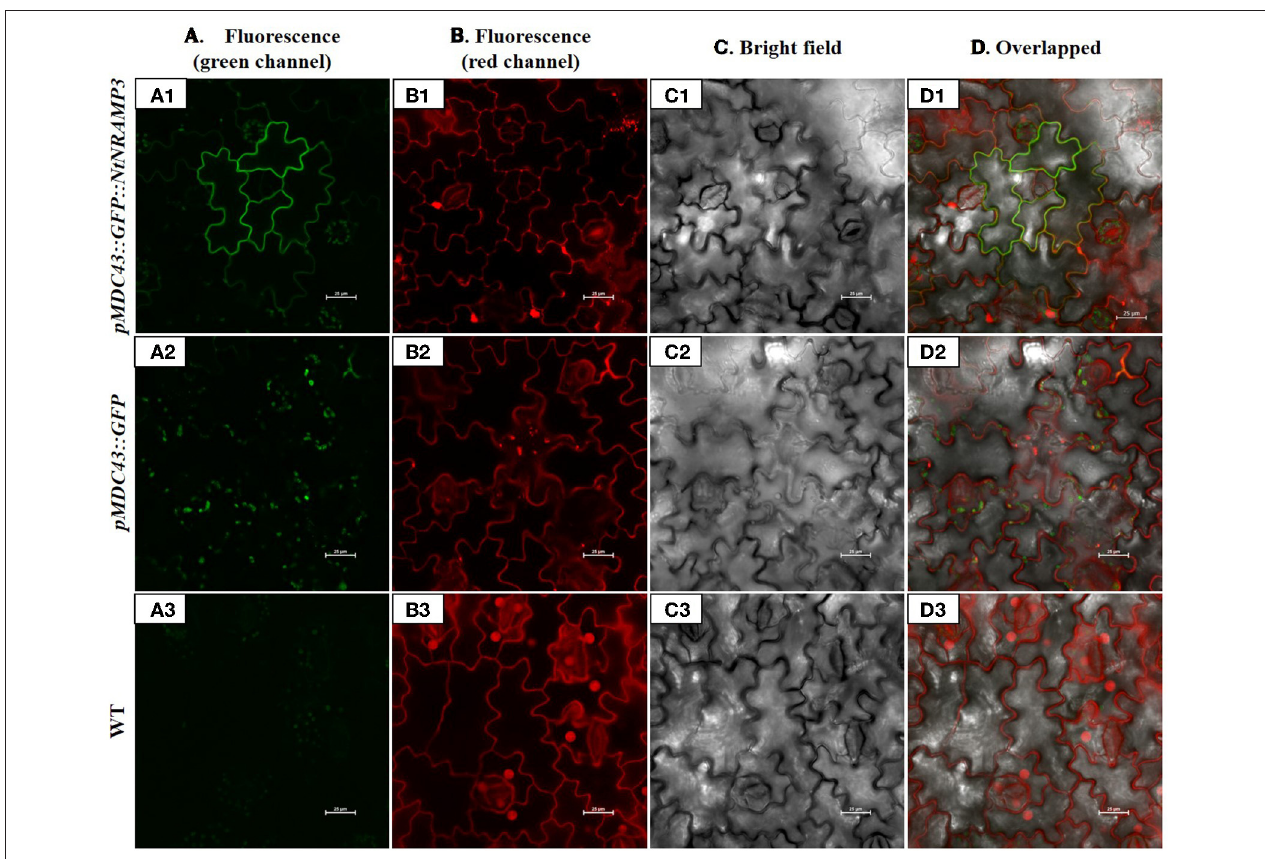
FIGURE 3 | Subcellular localization of NtNRAMP3 in the epidermal cells of tobacco leaves. A. tumefaciens GV3101 strains containing the pMDC43::GFP [control empty vector (A2,B2,C2,D2) ] or pMDC43::GFP::NtNRAMP3 (A1,B1,C1,D1) were used for transient expression in N. tabacum leaves. After 1–4 days from infiltration leaves were observed under a confocal microscope. (A) GFP fluorescence (green channel); (B) PI (propidium iodide) signal in the cell wall (red channel); (C) bright-field images; (D) merged images. WT tobacco plants (A3,B3,C3,D3) were used as a negative control for the GFP signal. The white bar represents 25 µ